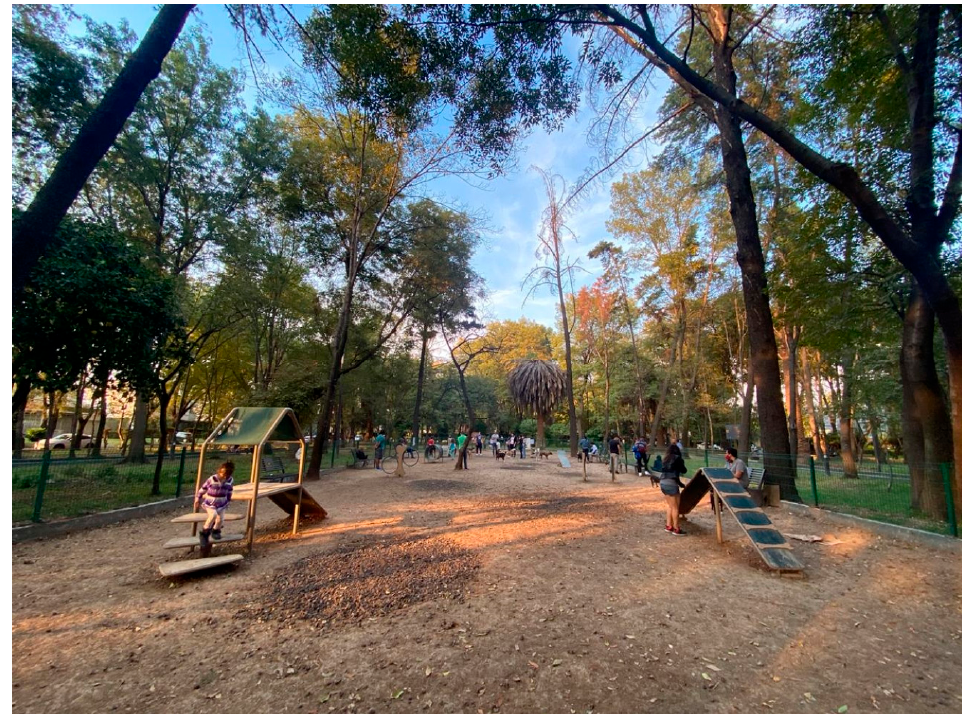
Figure 8. One of the three UGS near Participant 1’s